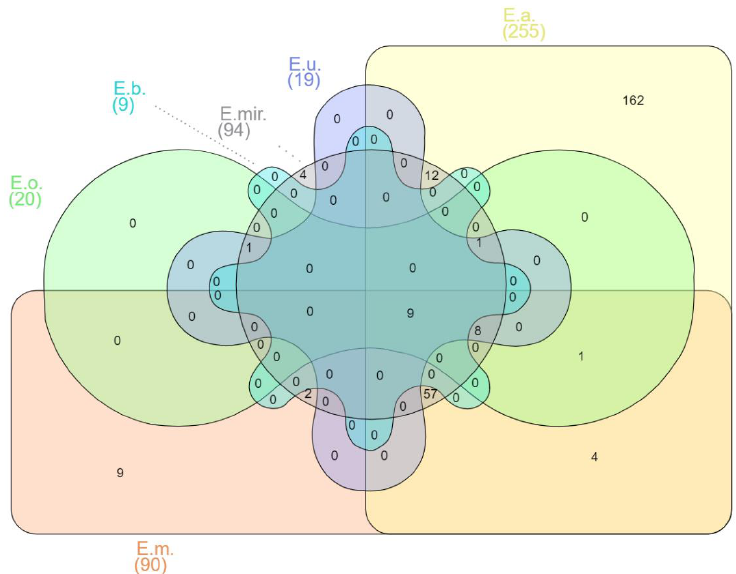
Figure 1. Venn diagram of shared virulence factor genes of Elizabethkingia spp. E.m. — E. meningosep- tica ; E.a. — E. anophelis ; E.mir. — E. miricola ; E.o. — E. occulta ; E.u. — E. ursingii ; E.b. — E. bruuniana. Ed- wards mode was used to process virulence factor gene outputs for Venn diagram visualization with InteractiVenn